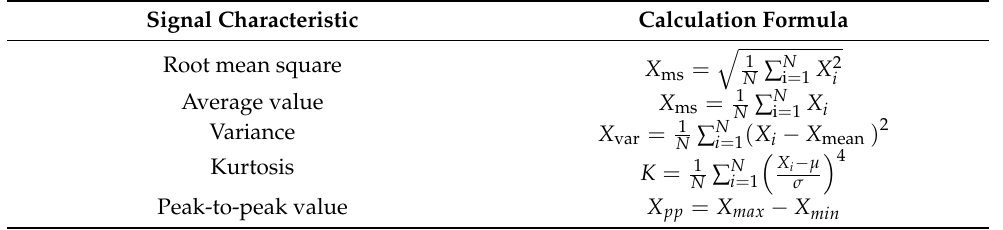
Table 1. Signal characteristic value formula. Signal